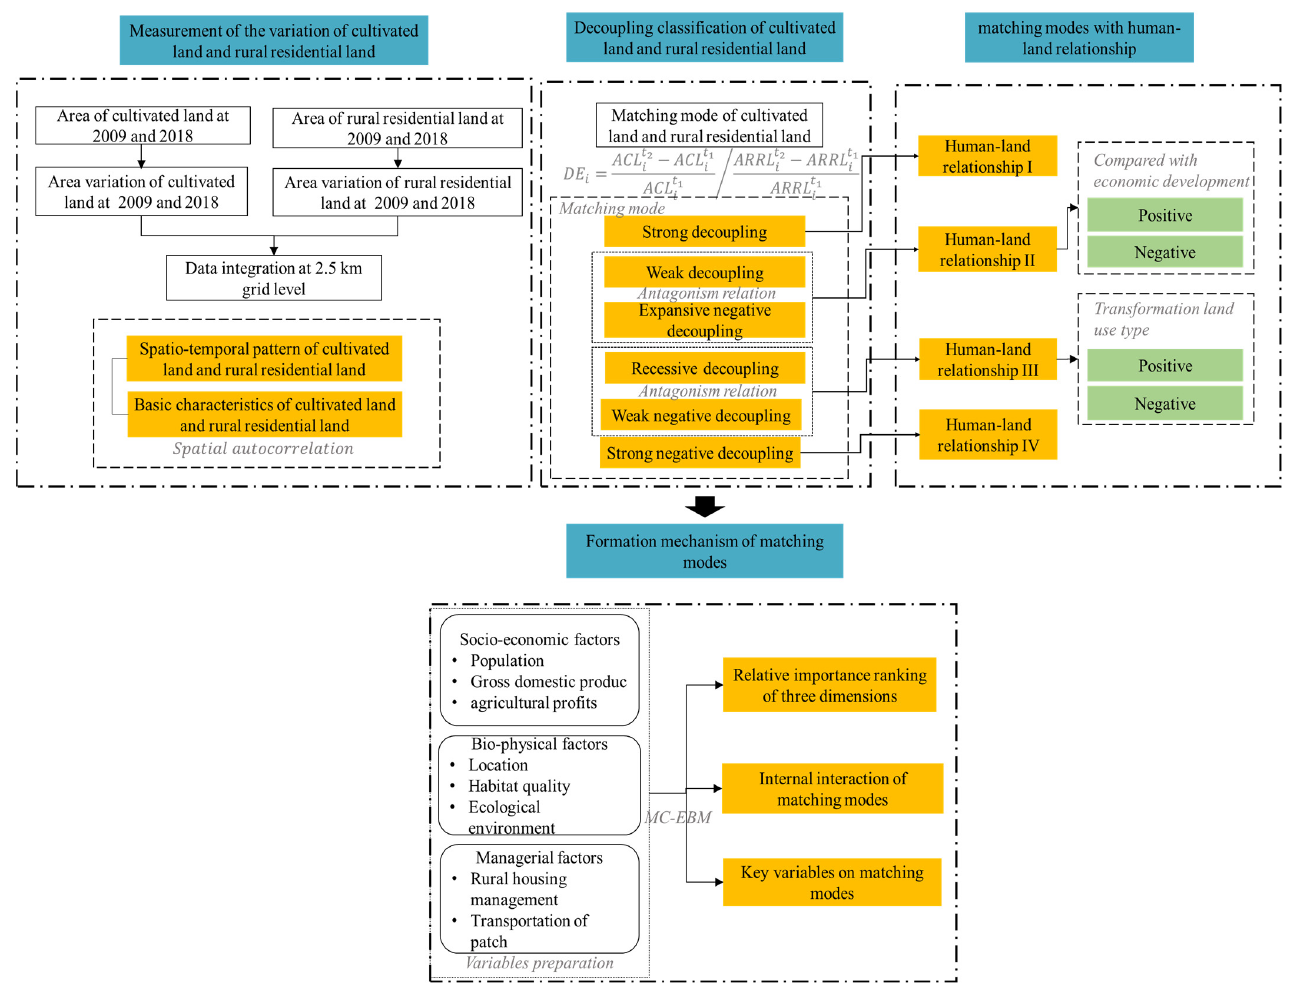
Figure 2. Flowchart of the method.